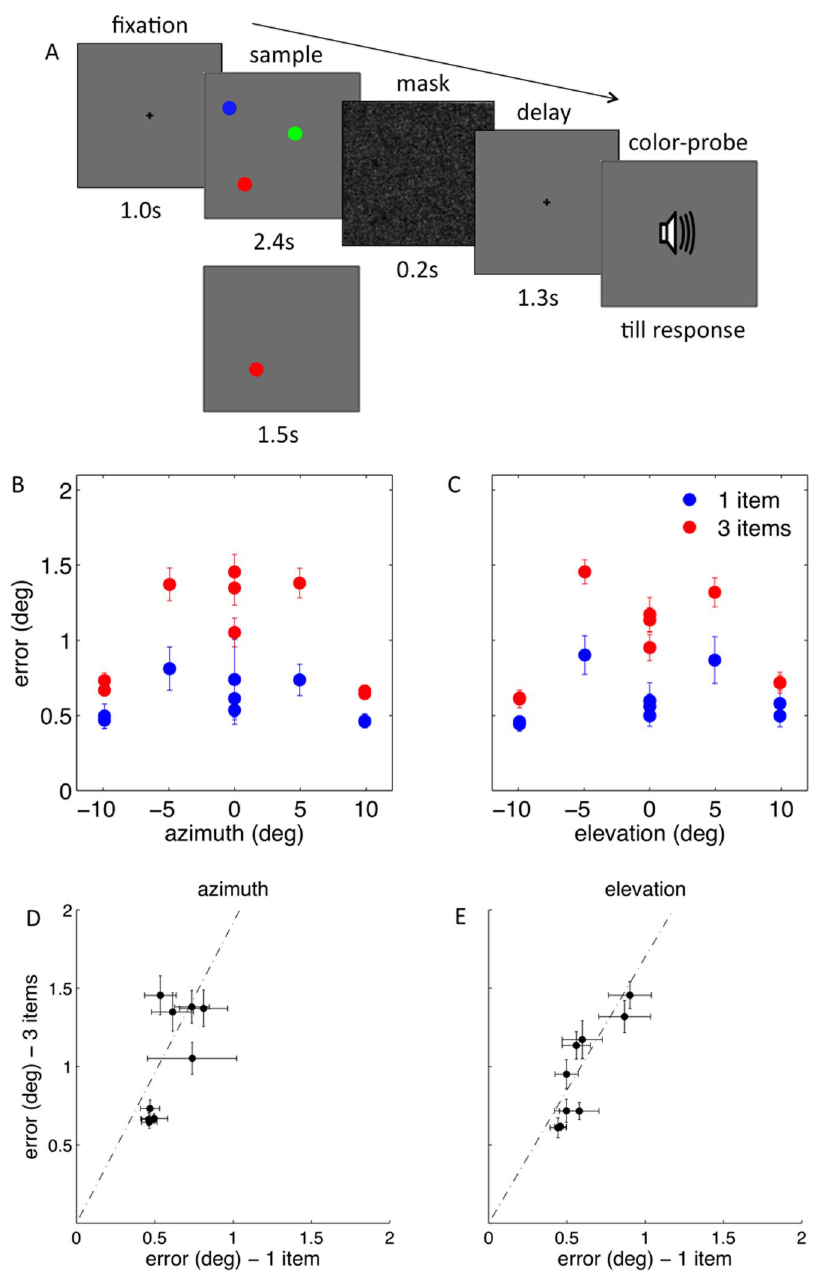
Figure 1. Memory load and target location affect spatial recall. (A) Participants memorized the location of either one or three items. After a pattern mask and blank interval, the target to be recalled was indicated by its color. (B) The standard deviation of the recall error is shown as a function of target azimuth, when the memory load is one (in blue) and three (in red). (C) The recall error as a function of target elevation. The variable error is smaller for targets closer to the center and boundaries of the display compared to intermediate positions. (D) The standard deviation of the recall error when memory load was three is shown as a function of the error standard deviation when memory load was one for target azimuth, and (E) elevation. Each point represents the group averaged error standard deviation at one of the nine target locations. The vertical and horizontal error bars are standard errors of the mean. The dash-dot line represents the group average best fitting multiplicative model.